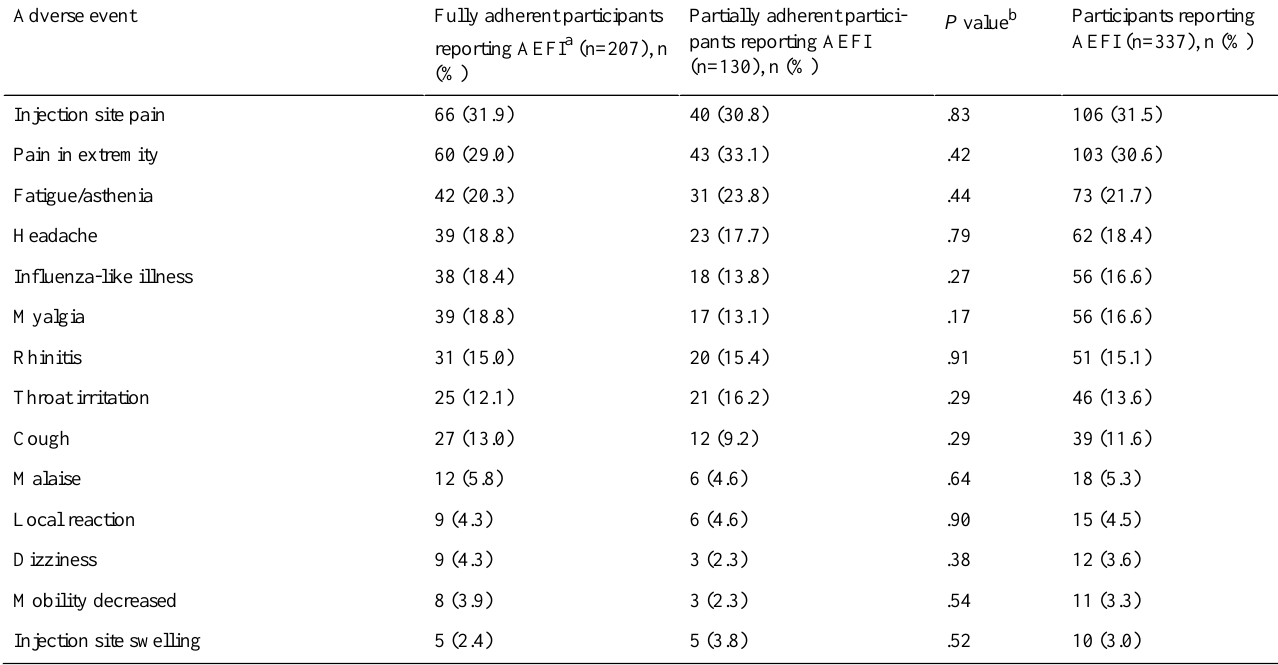
Table 2. Most common AEFIs according to app use